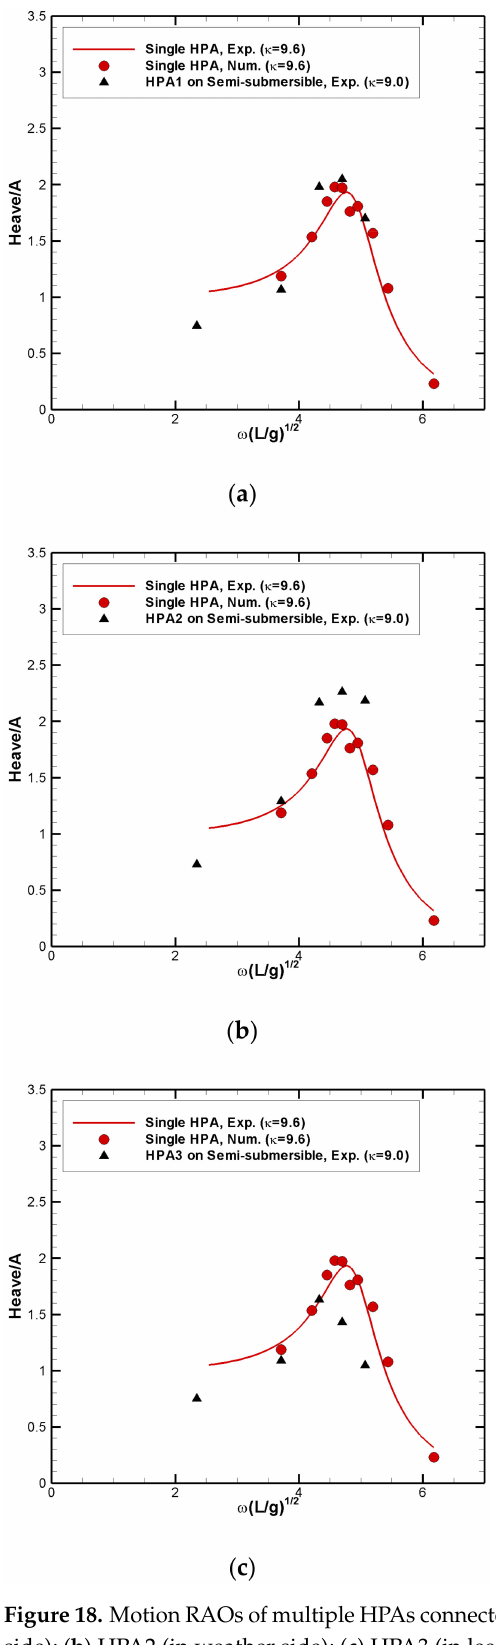
Figure 18. Motion RAOs of multiple HPAs connected to large semi-submersible; ( a ) HPA1 (in weather side); ( b ) HPA2 (in weather side); ( c ) HPA3 (in lee